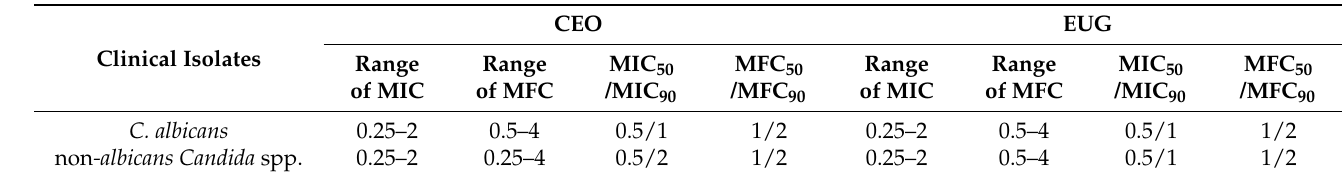
Table 2. The activity data of CEO and EUG expressed as a range of MIC (minimal inhibitory con ‐ centration) or MFC (minimal fungicidal concentration) [mg/mL] and MFC/MIC ratio against the reference strains of Candida spp.